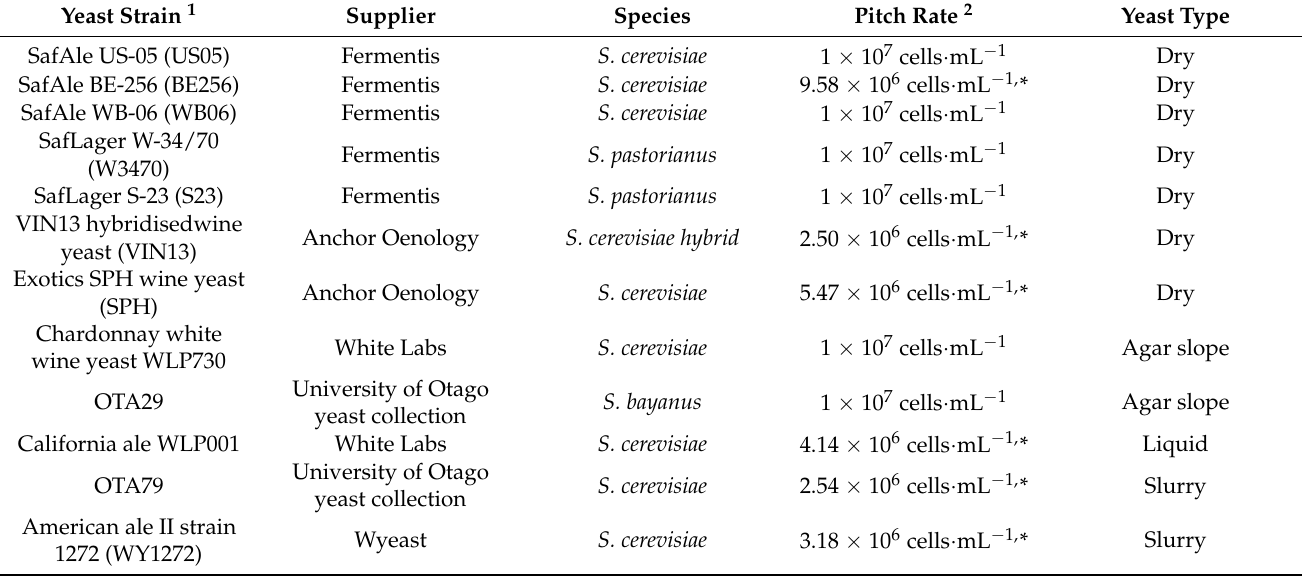
Table 1. Yeast characteristics and pitching